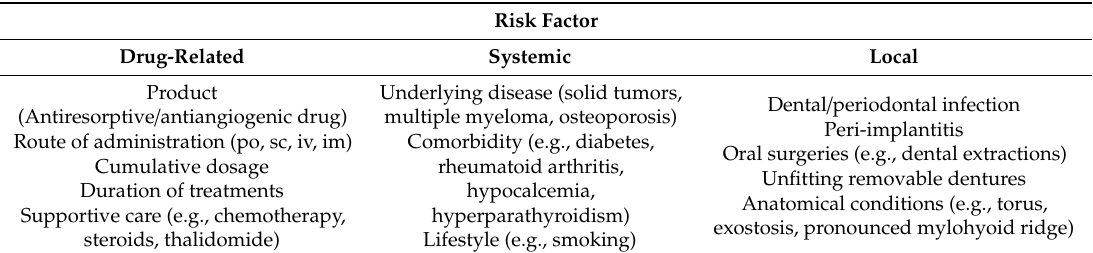
Table 1. Drug-related, systemic and local risk factors of Medication-Related Osteonecrosis of Jaws